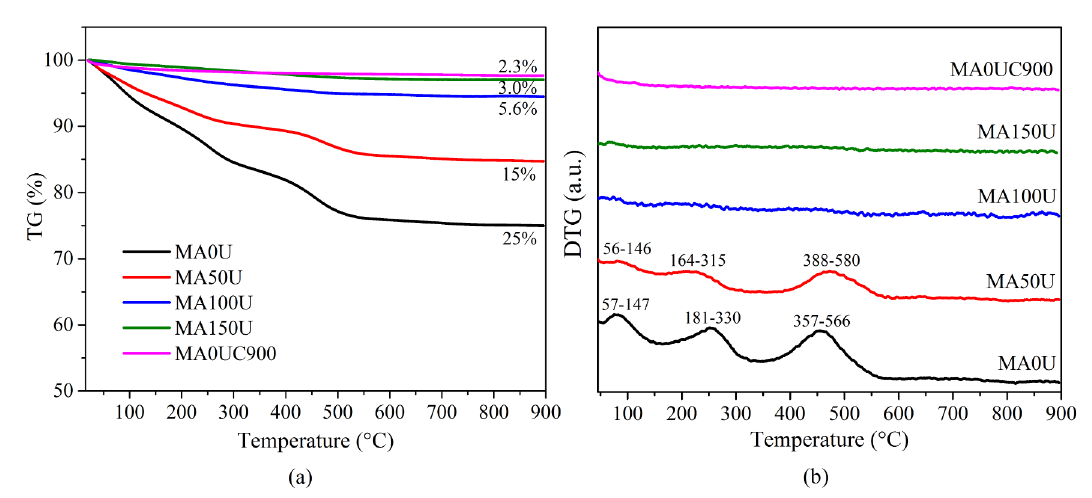
Figure 1. TG (a) and DTG (b) of the samples obtained without the use of urea excess, not calcined (MA0U) and calcined at 900 °C (MA0UC900), and with the use of 50% (MA50U), 100% (MA100U) and 150% (MA150U) of urea